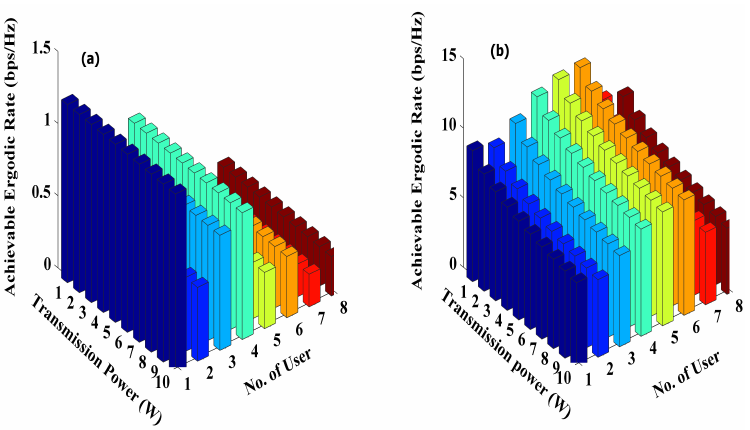
Figure 8. Estimated achievable ergodic rate when both gyre decoding and inverse T-transformation schemes are ( a ) absent and ( b )